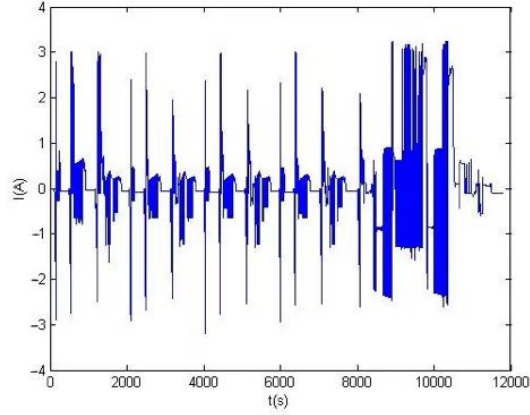
Figure 12. The I ‐ t curve at the loading profiles of NEDC.